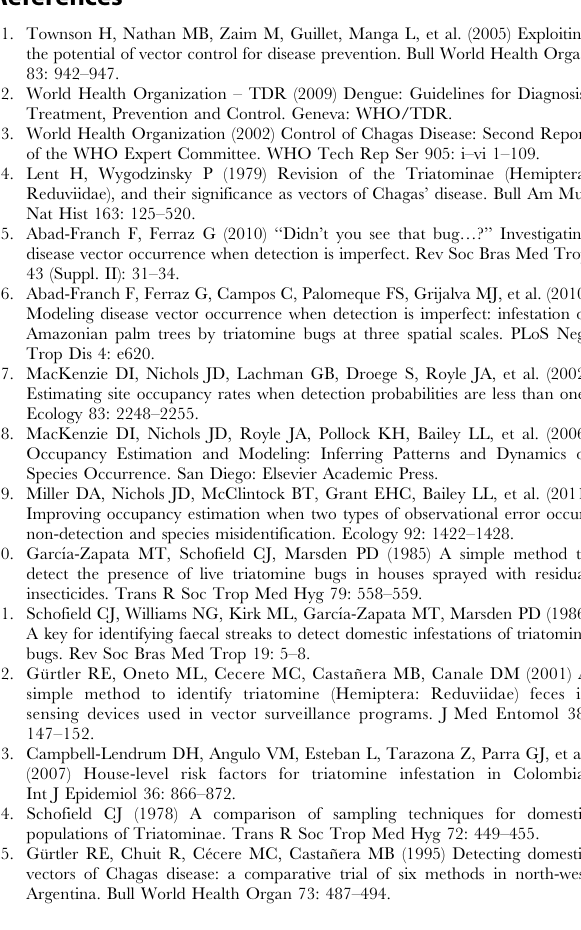
Table S1 The complete set of multiple detection-state site- occupancy models. AICc, Akaike information criterion corrected for sample size; D AICc, difference in AICc between each model